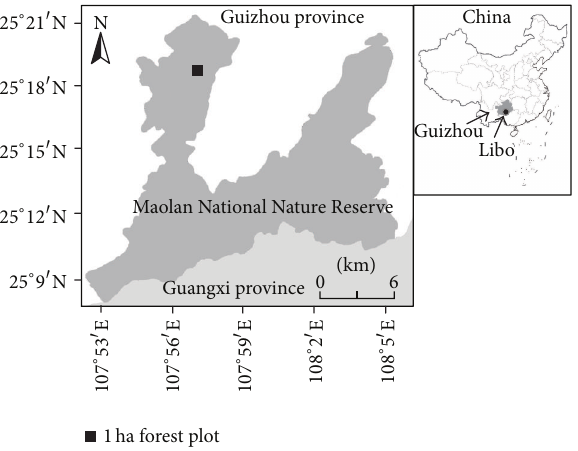
Figure 1: Location of the 1ha forest plot in the Maolan National Natural Reserve in Guizhou province, southwest